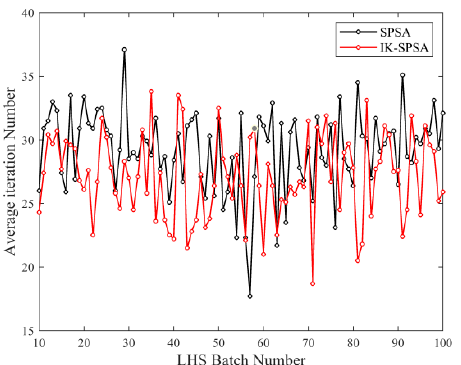
Figure 17. Average iteration number distribution at the same initial point.